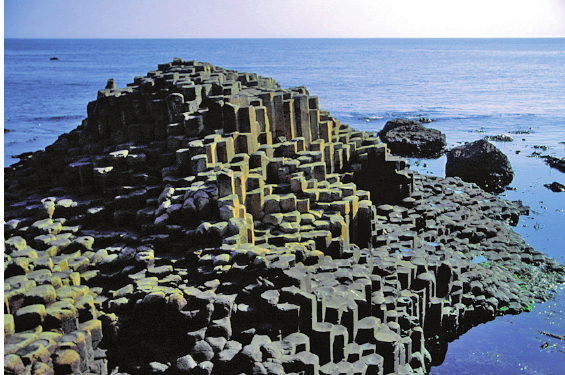
Fig. 3. The Giant’s Causeway, Northern Ireland (Photo Z.